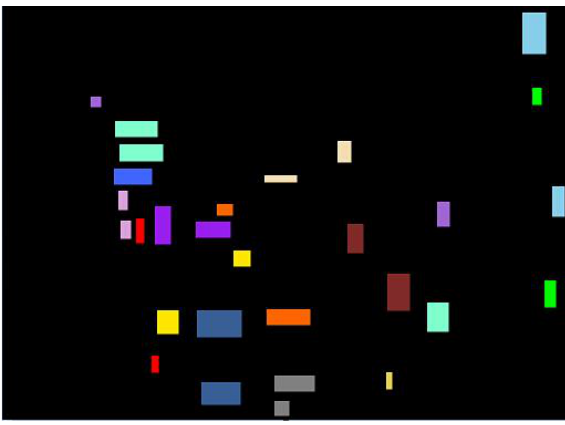
Figure 12. The illustration of the training samples for the Flevoland